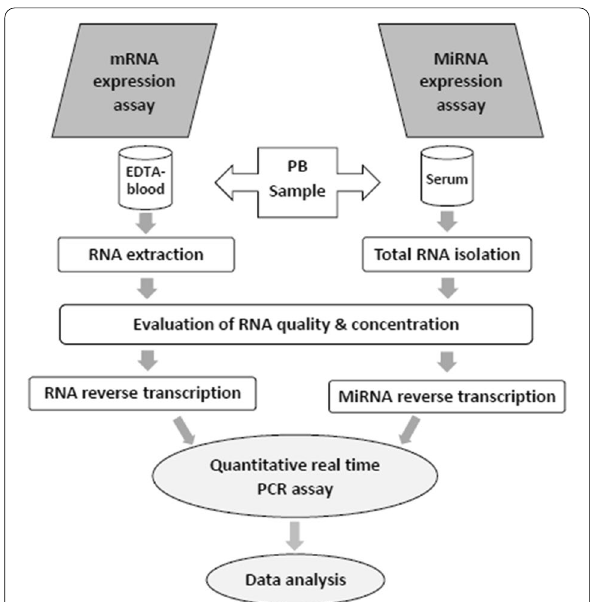
Fig. 1 Flowchart illustrating the study